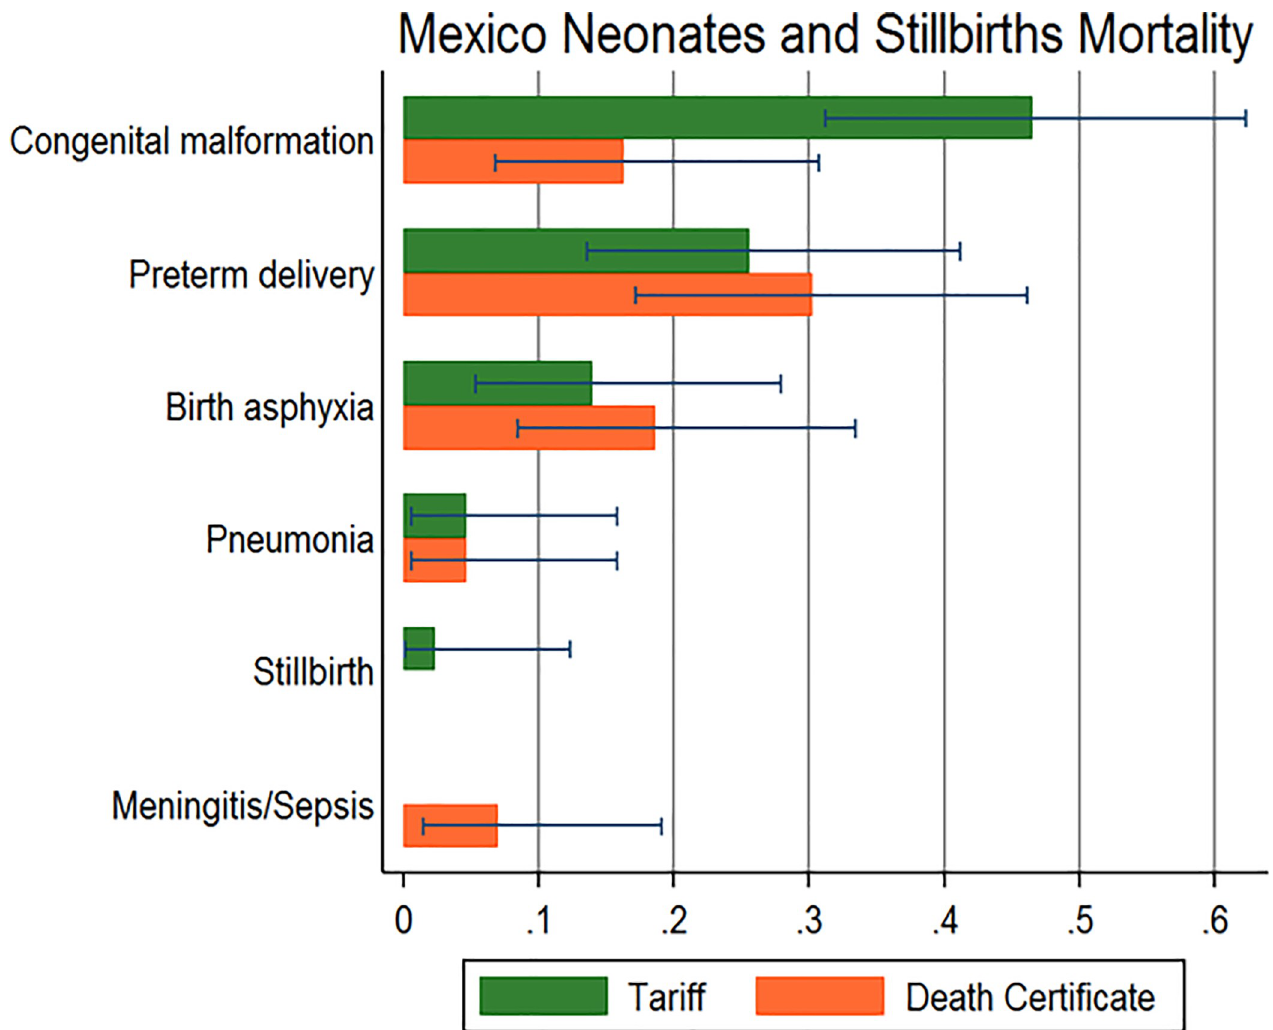
Fig 4. Comparison of neonate mortality fraction calculated by VAs vs. vital statistics, Hidalgo, Mexico 2009 (n = 1,104).